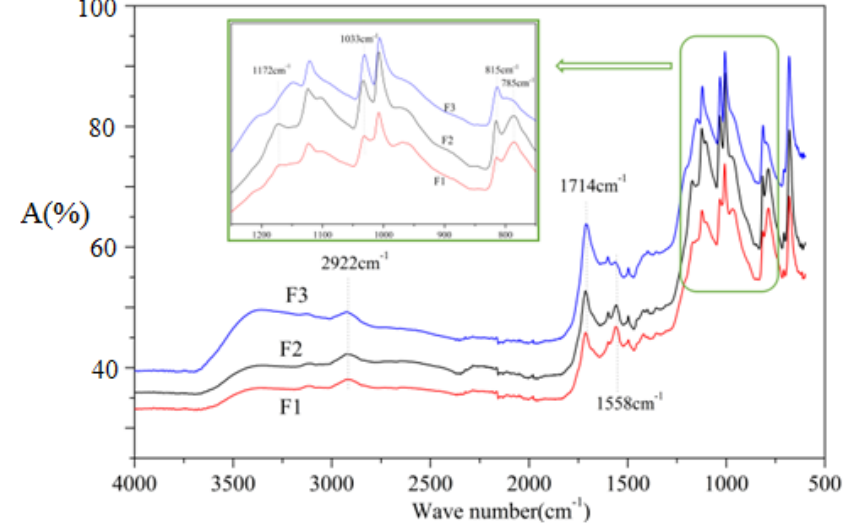
Figure 7. FTIR spectra of furanic-glyoxal foams without olive stone flour added.